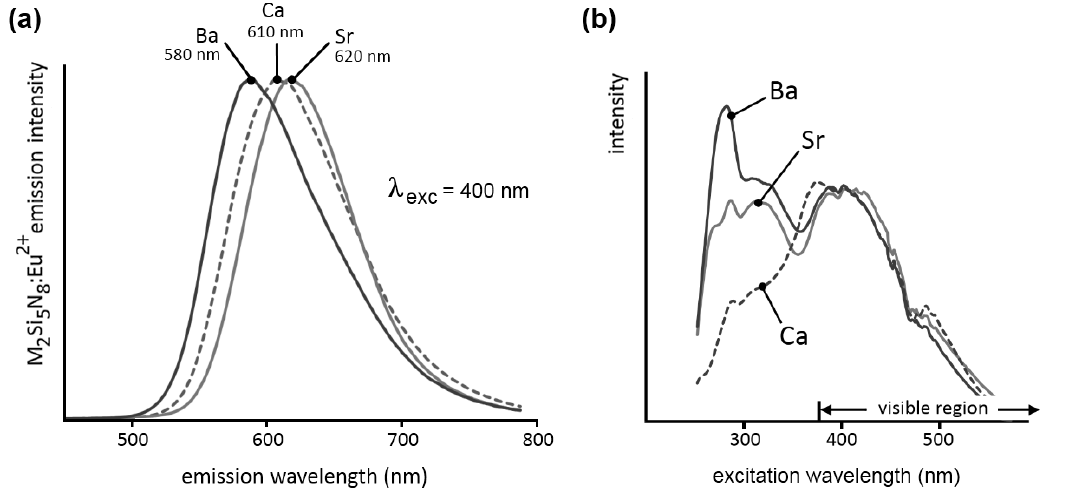
Figure 1. (a) Emission and (b) excitation spectra of M emission spectra were recorded for  the emission at 610 nm for M = Ca, 620 nm for M = Sr and 580 nm for M =